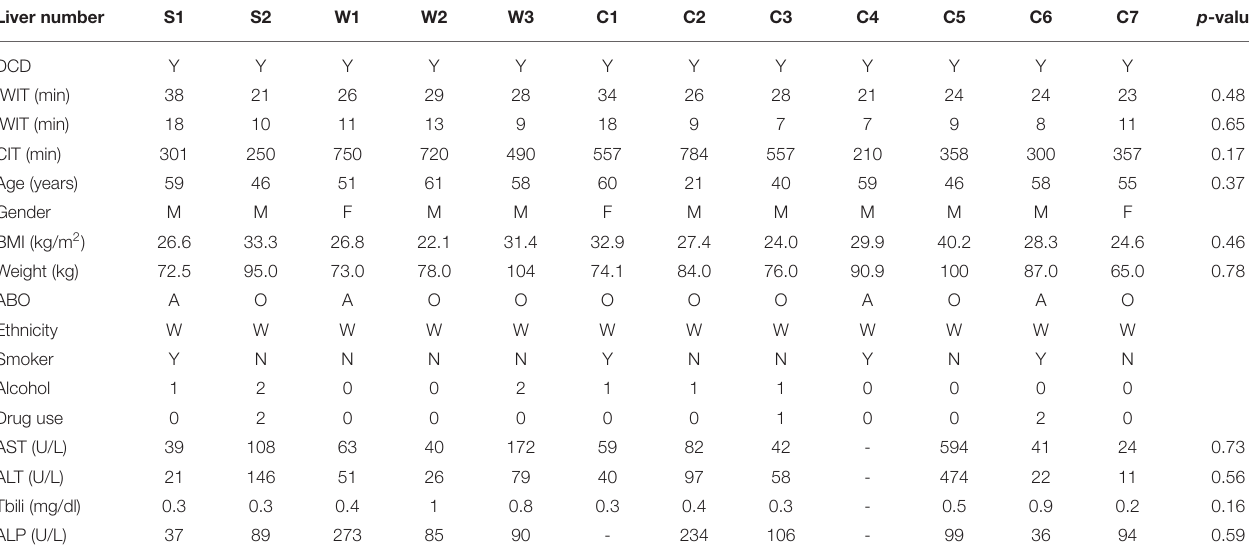
TABLE 1 | Detailed characteristics of discarded liver grafts undergoing normothermic machine perfusion (NMP). Liver